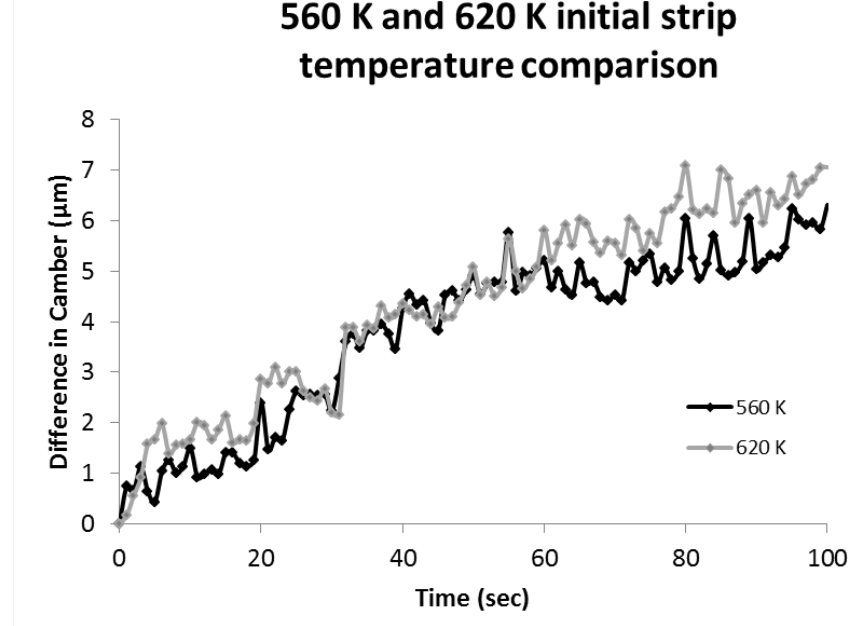
Figure 12. Comparison of roll camber evolution for rolling strips with different temperatures (560 Κ and 620 Κ).